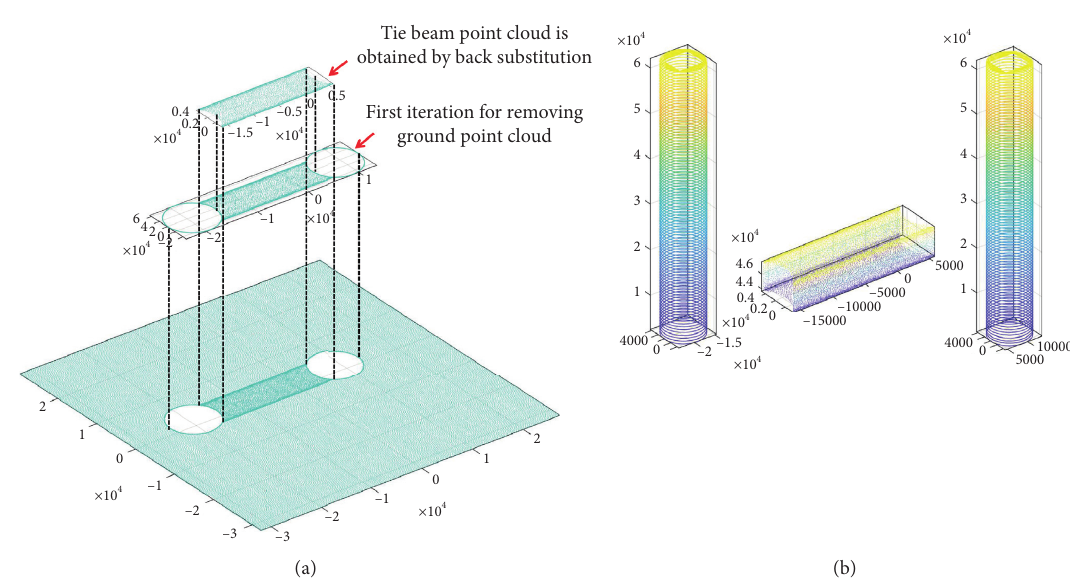
Figure 9: Effect of point cloud projection filtering segmentation: (a) projection filtering segmentation process; (b) point cloud of the column and tie beam after